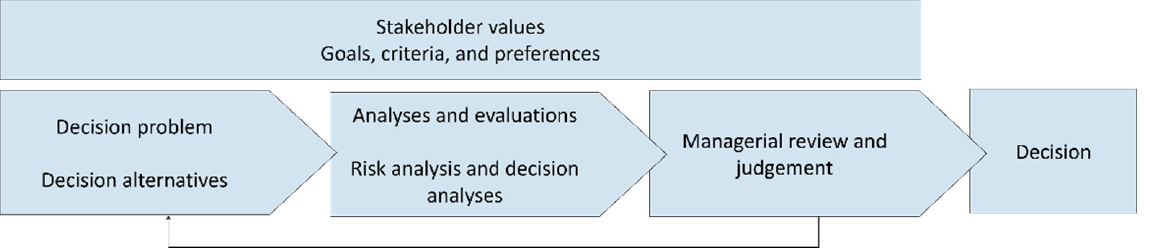
Figure 2. Decision-making process inspired by Aven [7].